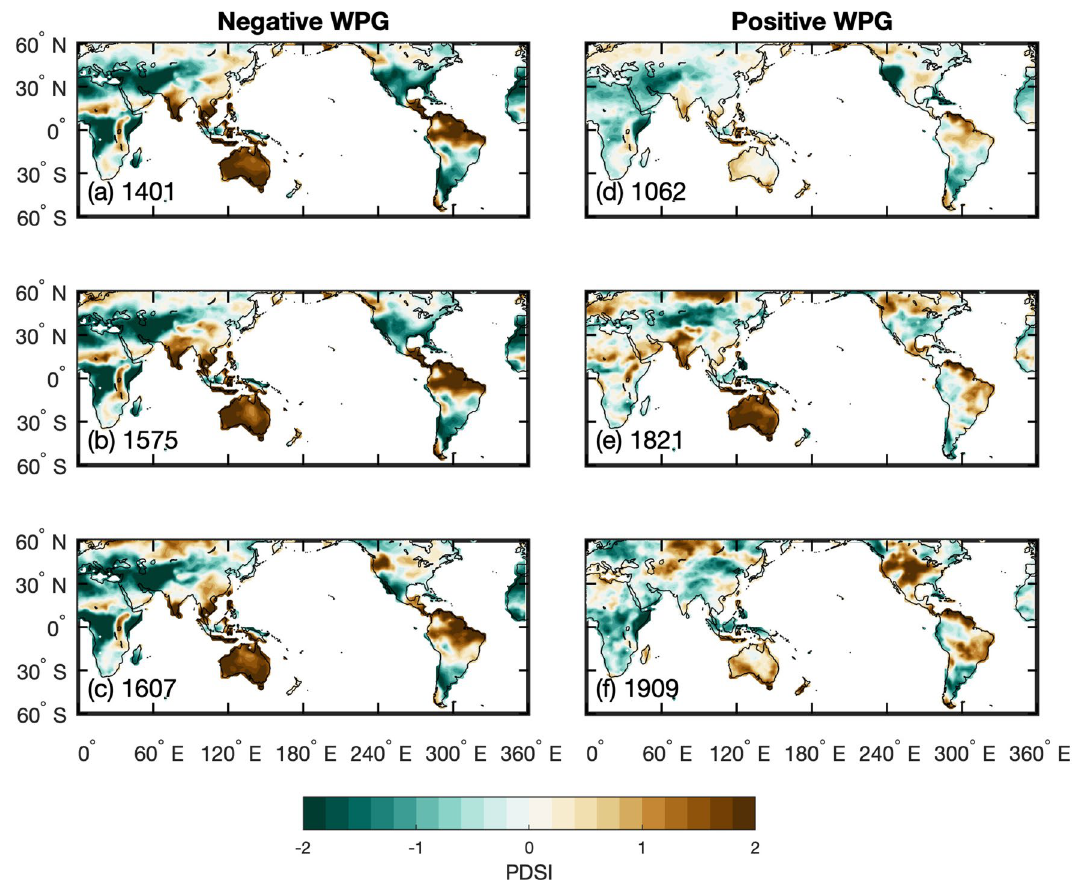
Figure 6. Composites of 20-year mean anomalies of the spatial Palmer Drought Severity Index in 34 PHYDA (PDSI; 30°N–30°S, 100°E–75°W) for the most extreme 20-year periods of ( a - c ) negative and ( d - f ) positive West Pacific Gradient (WPG) 46 over the past Millennium. The anomaly is calculated relative to the 1001–2000 mean. The composites were based on the SST patterns shown in Fig. 5. The 20-year period is centred on the indicated year: for example, 1401 is the mean of 1392 to 1411. Location of the WPG grid boxes after Hoell and Funk 24 indicated by black rectangles. Figures created in Matlab R2020b (https:// au. mathw orks.